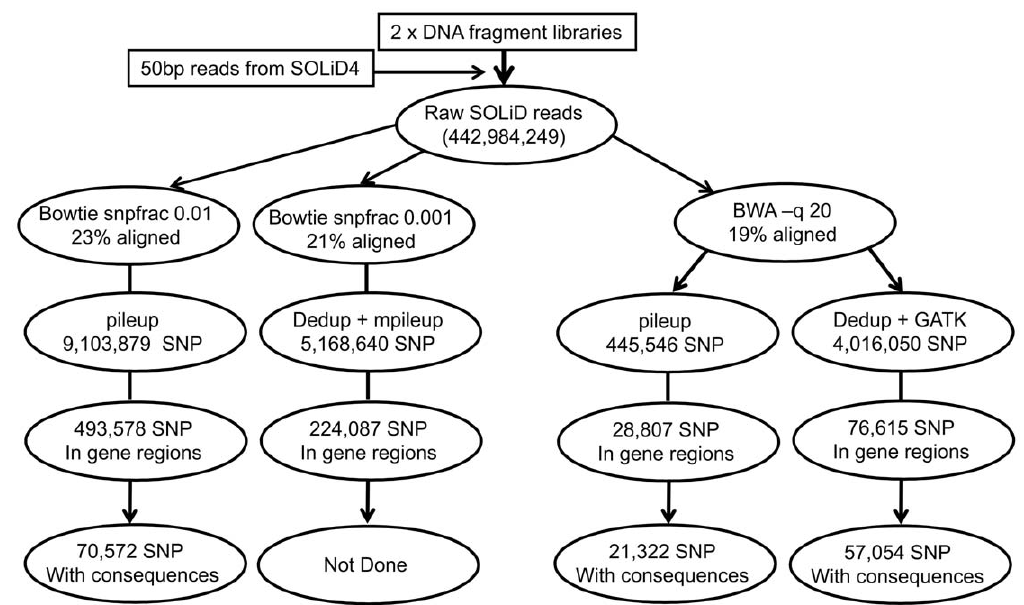
Figure 1. SNP discovery pipeline using Bowtie and BWA.